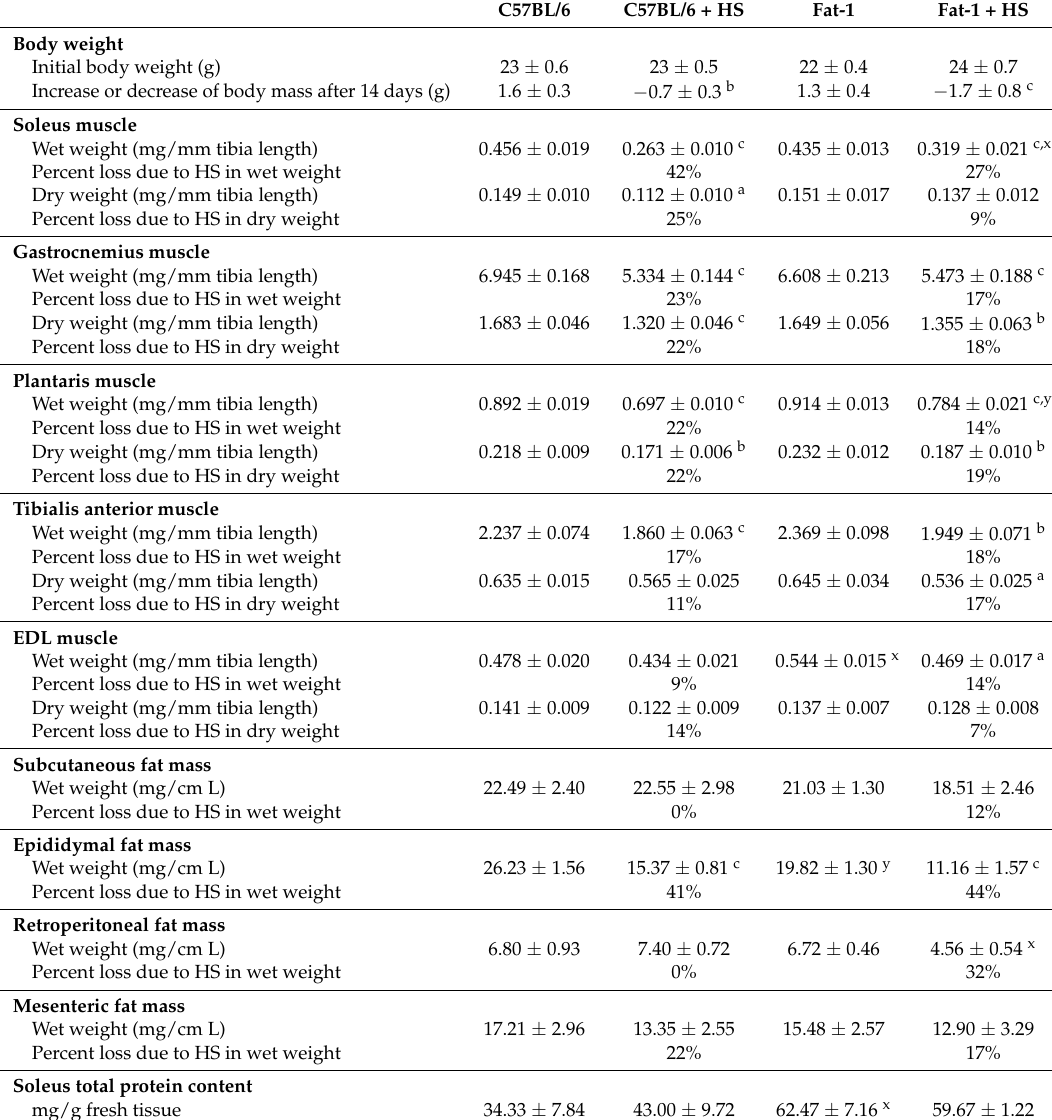
Table 1. Body weight, skeletal muscles and fat depots mass and soleus protein content of the four groups: C57BL/6, C57BL/6 + HS, Fat-1, and Fat-1 + HS. C57BL/6 C57BL/6 + HS Fat-1 Fat-1 +